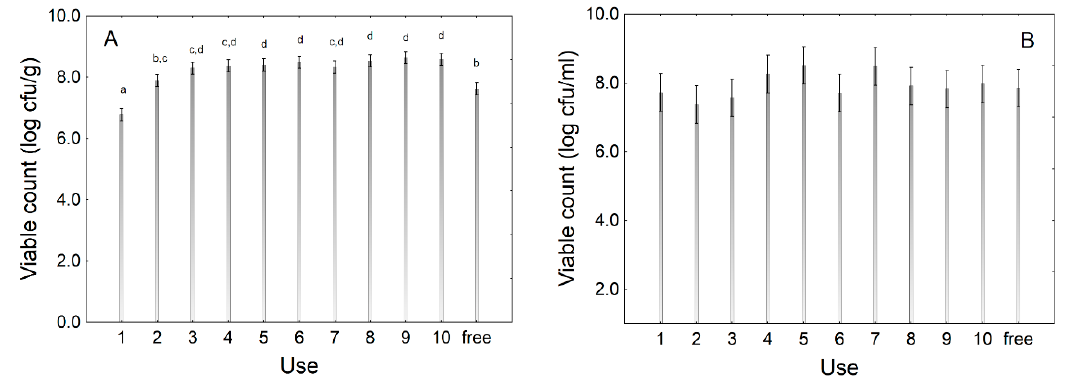
Figure 2. Viable count of S. cerevisiae W13 on apple pieces (experiment A) as a function of the number of uses ( A ) and after 24 h of fermentation in cider ( B ). Bars denote 95% confidence intervals. In ( A ), the letters indicate significant differences (one-way ANOVA and Tukey’s test, p < 0.05), while in ( B ), the samples were not significantly different ( p > 0.05). Free, free cells (control).